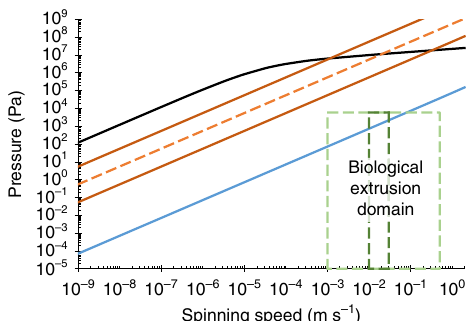
Fig. 8 The effect of using an alternative working fl uid on pressure requirements. The use of lower viscosity fl uids (in the same geometry used by Breslauer with a no-slip wall condition) reduces the pressure required compared to fi broin ( black : η 0 = 1700 Pa s) when the working fl uid is sericin ( orange dashes : η 0 = 7.6 Pa s; orange line : ± order of magnitude variation), or water ( blue : η = 8.9 x10 − 4 Pa s). Water only just reaches the biological extrusion domain, with the higher natural spinning speeds remaining unattainable. The biological extrusion domain is split into natural ( dark green dashes ) and forced ( pale green dashes ) spinning